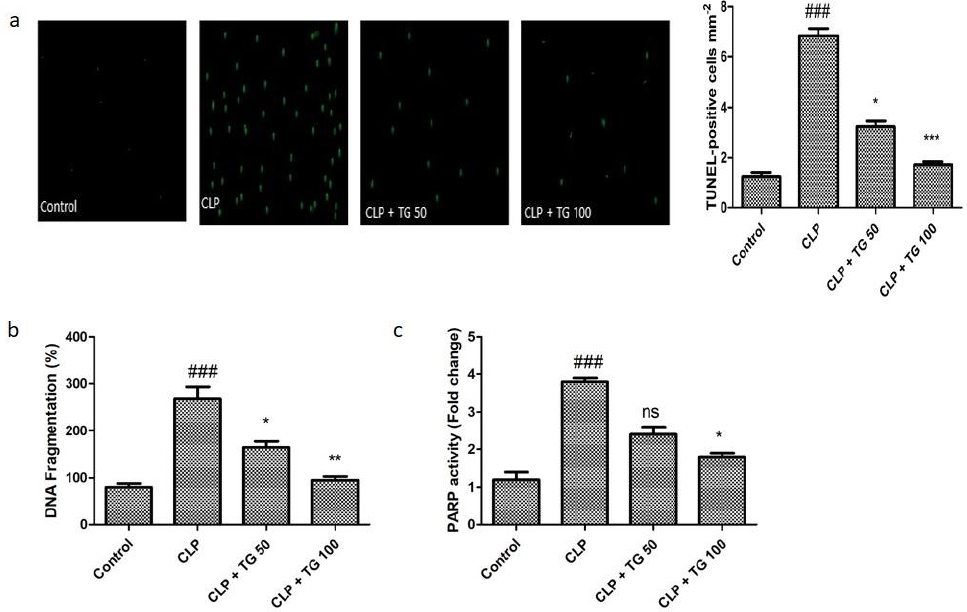
Figure 2. ( a ) Representative fluorescent images of TUNEL staining performed on paraffin section of rat heart in each group; Scale bar 5 mm= 25 µm. Green color demonstrated TUNEL-positive nuclei and intensity of the same is plotted as bar graph near the TUNEL images. ( b ) Cardiac cell death markers DNA fragmentation and ( c ) poly(ADP-ribose) polymerase (PARP) activity assay. Both DNA fragmentation and PARP activity were significantly increased in CLP-rats, and TG (50 and 100 mg/kg) treatment ameliorated elevated levels, dose-dependently. Values represented as means ± SD and n = 12/group. One-way analysis of variance (ANOVA), followed by Tukey’s test were used for statically analysis (Significance level * p < 0.05). Where ### p < 0.001 compared to control group, whereas ns, * p < 0.05, ** p < 0.01 and *** p < 0.001 compared with CLP group animals.